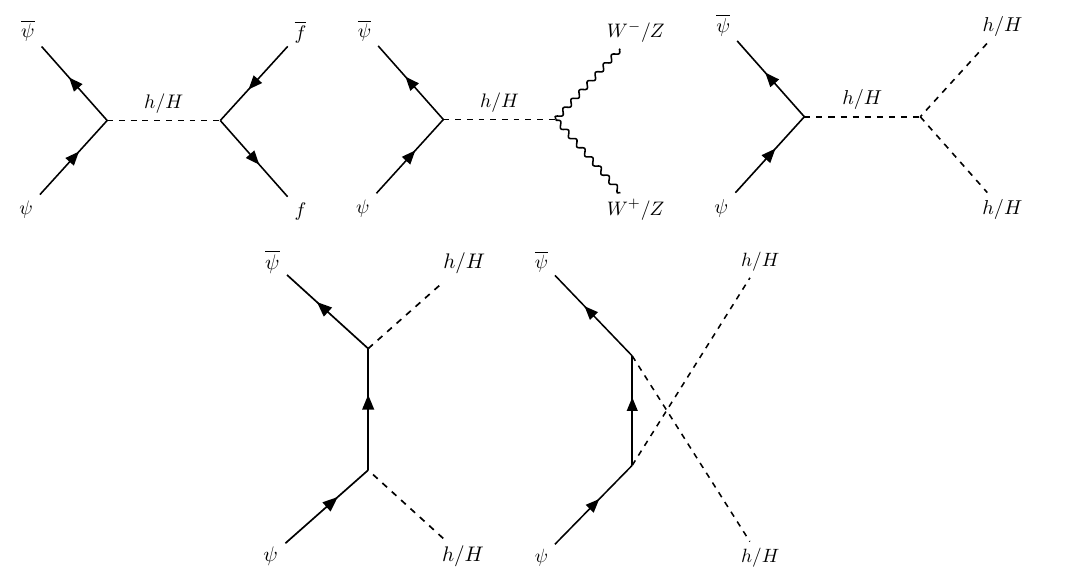
Figure 1 . Feynman diagrams for the fermion DM annihilation into SM and h=H particles when (cid:11) = 0 ; (cid:25)= 2. Here f refers to a SM 6